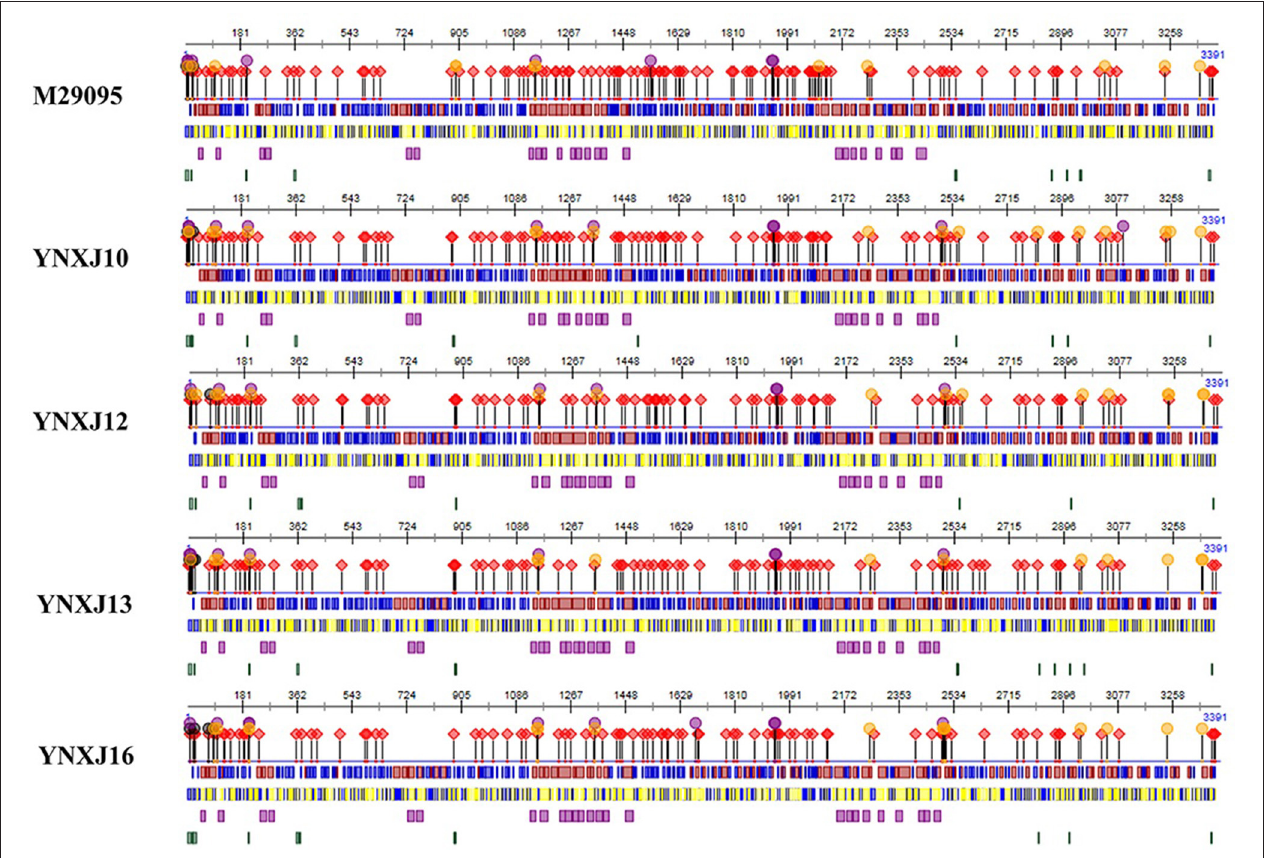
FIGURE 5 | Secondary structure prediction of the structural and non-structural proteins for DEN2SS M29095 and YNXJ10, YNXJ12, YNXJ13, and YNXJ16. The purple dots denote the RNA-binding region, the black dots denote the nucleotide-binding region, the red rhombuses denote the protein-binding region, and the yellow dots denote the DNA-binding region. Red and blue in the first line represent the strand and helix regions, respectively. Yellow and blue in the second line represent the buried and exposed regions, respectively. Purple in the third line indicates the helical transmembrane regions, and green in the fourth line represents the disordered regions. The first map is M29095, and the second, third, fourth, and fifth maps are YNXJ10, YNXJ12, YNXJ13, and